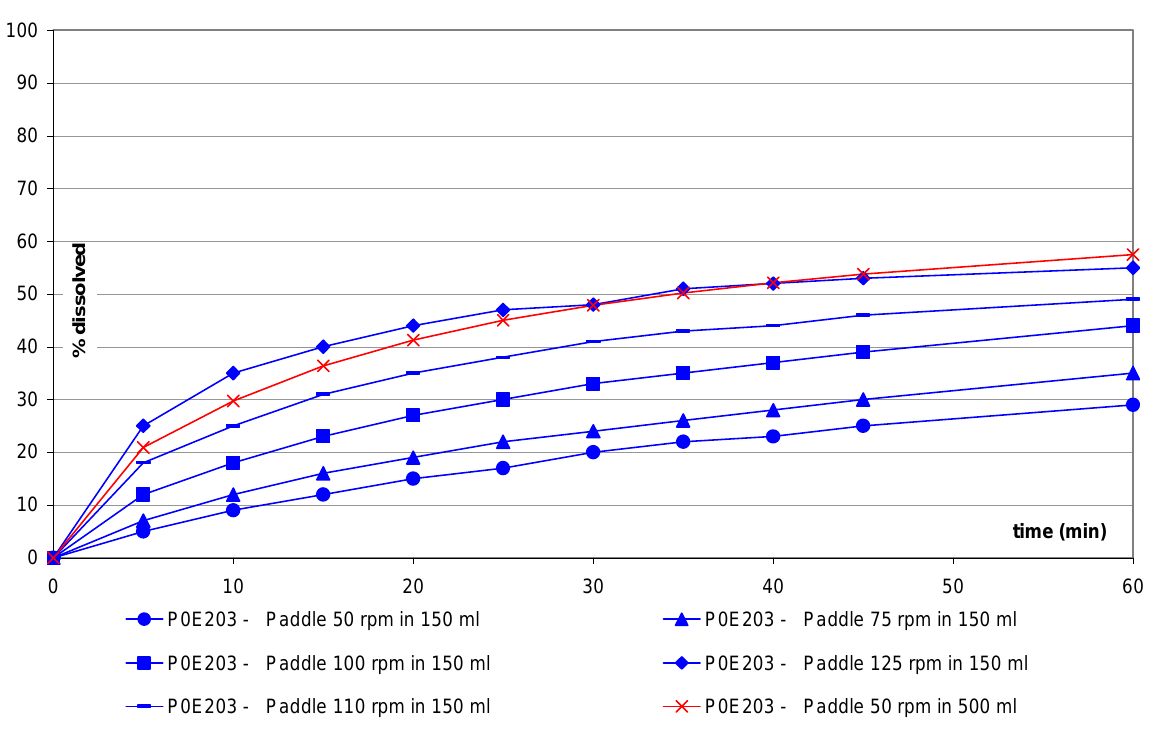
Figure 2. Dissolution profiles for prednisone tablets with small vessel accessories versus USP method with one liter vessel.